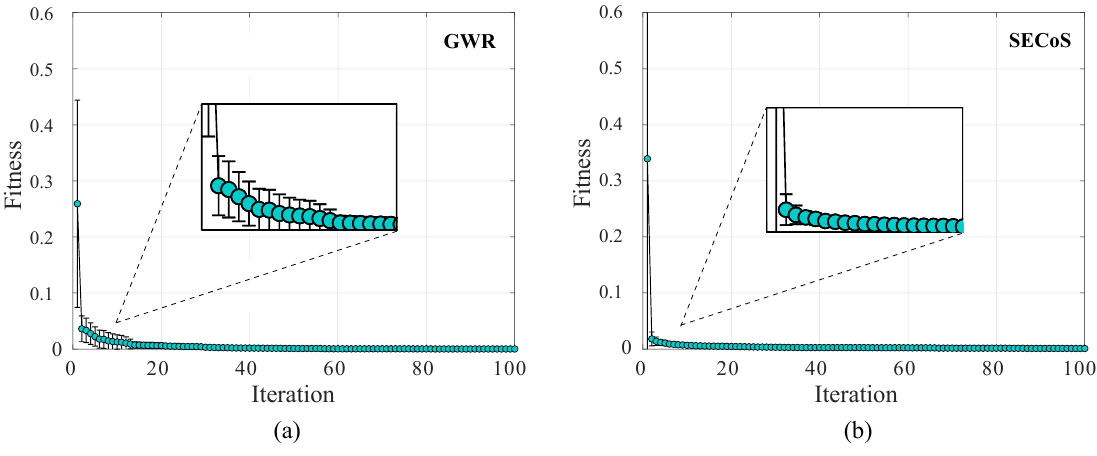
Figure 9. Average fitness value of the best-evolved detectors by using the artificial bee colony (ABC) algorithm in the 30 independent runs on dataset D-2. The detectors used the MNF feature extraction technique: ( a ) GWR detector; ( b ) SECoS